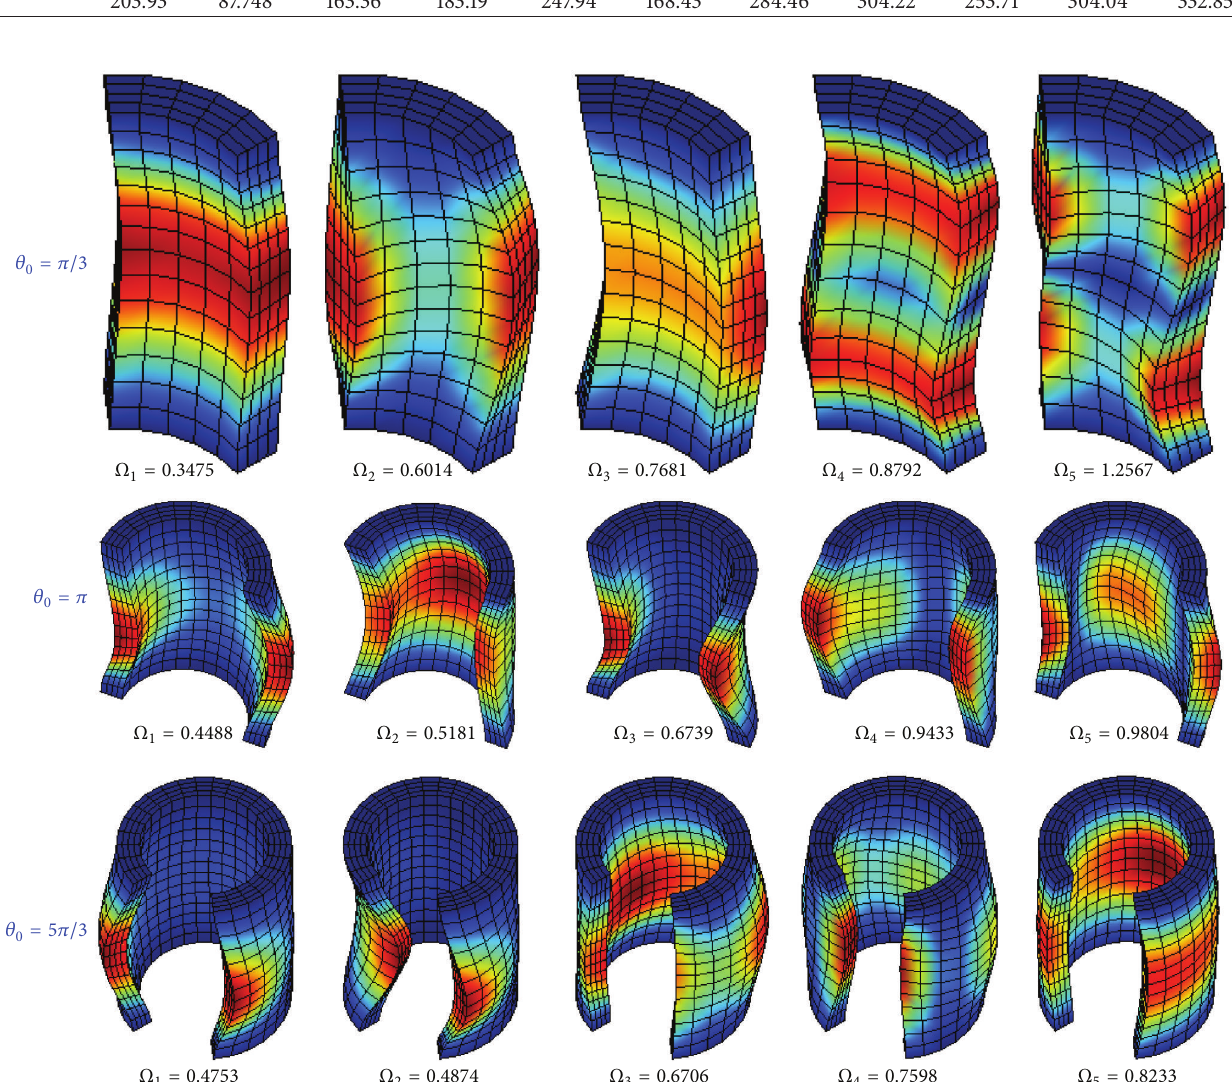
Figure 4: Mode shapes of an isotropic cylindrical shell with CFCF boundary conditions and various circumferential